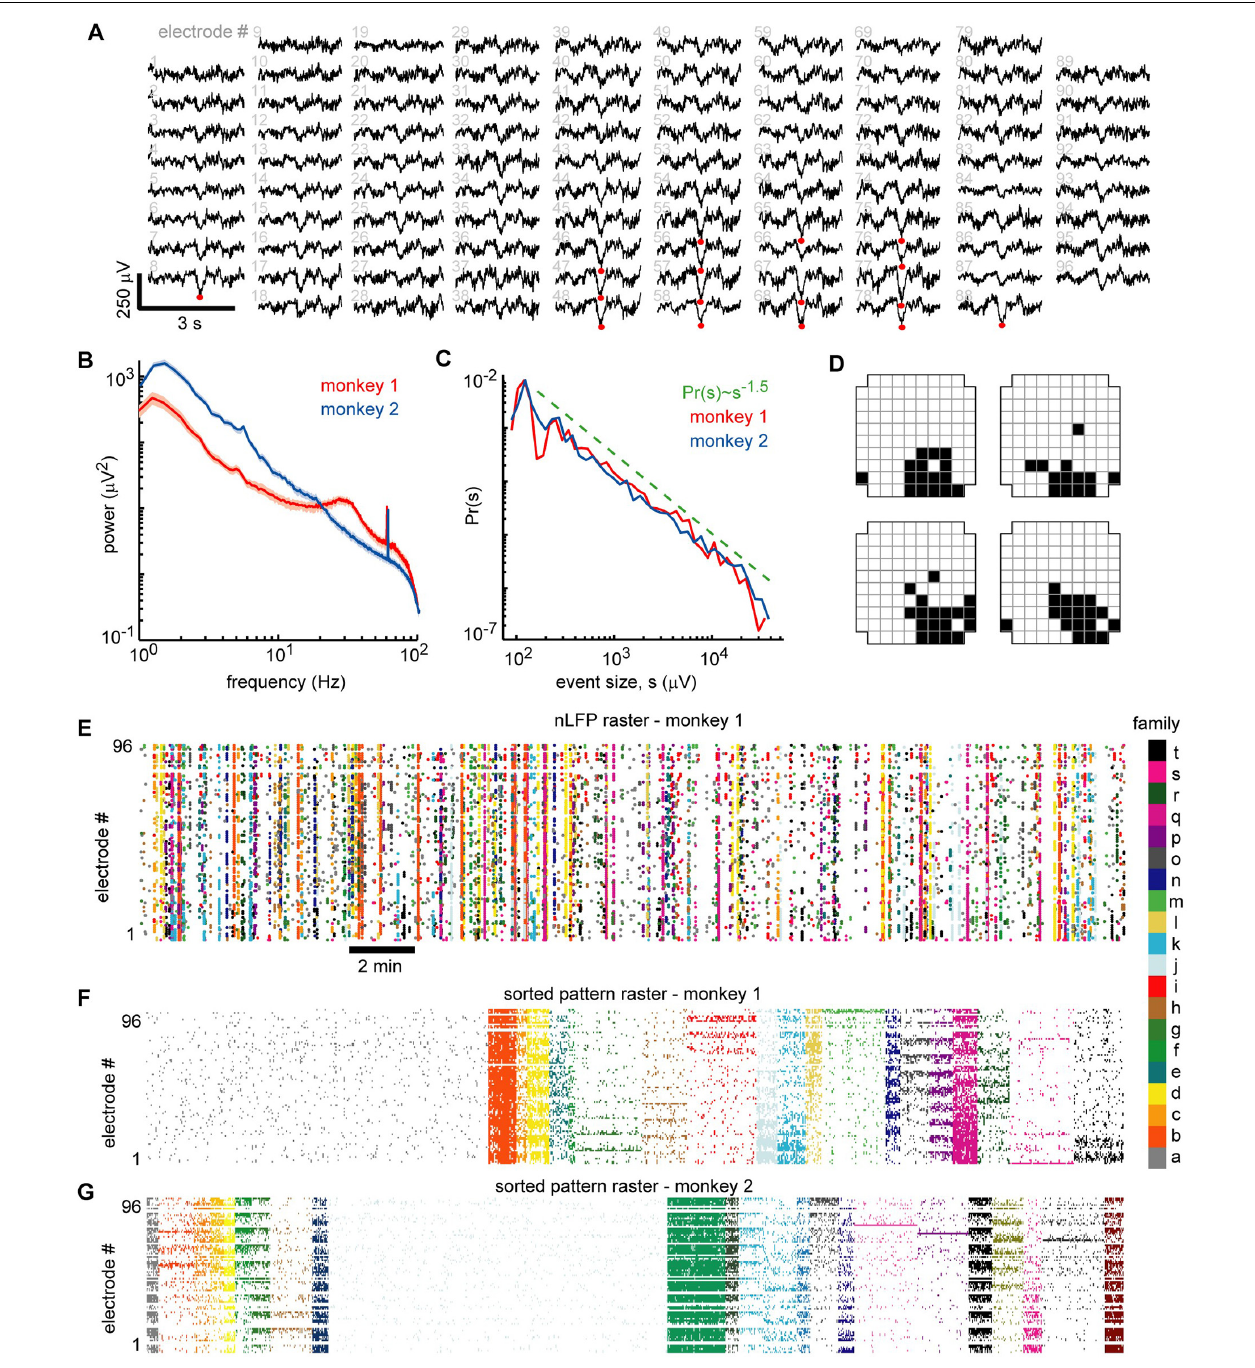
FIGURE 2 | Ongoing neuronal avalanches are composed of repeating spatial nLFP patterns. (A) Displayed are 3 s LFP recordings arranged to match the spatial layout of the 96 recordings sites. Multiple nLFPs (red dots) often occurred together within ∼ 100 ms across multiple sites—we defined such occurrences as “population events” (see Experimental Procedures). (B) Power spectra of LFP were broadband showing that low-frequency fluctuations dominate the signal. A prominent ∼ 30 Hz oscillation was present in monkey 1 (see also Miller et al., 2019). All recording sites were analyzed—median (line) and lower to upper quartile (shaded region) are shown. (C) Distributions of population event sizes s demonstrate that the activity is neuronal avalanches, defined by Pr(s) ∼ s -1.5 (Beggs and Plenz, 2003; Petermann et al., 2009). (D) The spatial locations of nLFP avalanches were represented with a binary pattern (Yu et al., 2011). The upper left pattern corresponds to population event in panel (A) . The other three patterns were similar but occurred at different times and are shown as typical like-examples extracted by our algorithm use. (E) Raster of all nLFP times and locations. Vertical clusters of nLFPs with matching color belong to one avalanche. (F) Avalanches were sorted into families with like patterns. The sorted avalanche raster of monkey 1 is shown. Color code identifies family and is same as in panel (E) . Note that family a (gray, left) is comprised of typically small avalanches that were not similar to many others. (G) Sorted avalanche raster of monkey 2.